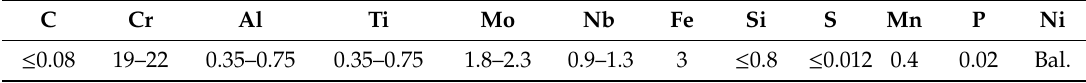
Table 1. The chemical composition of GH3039 superalloy (wt